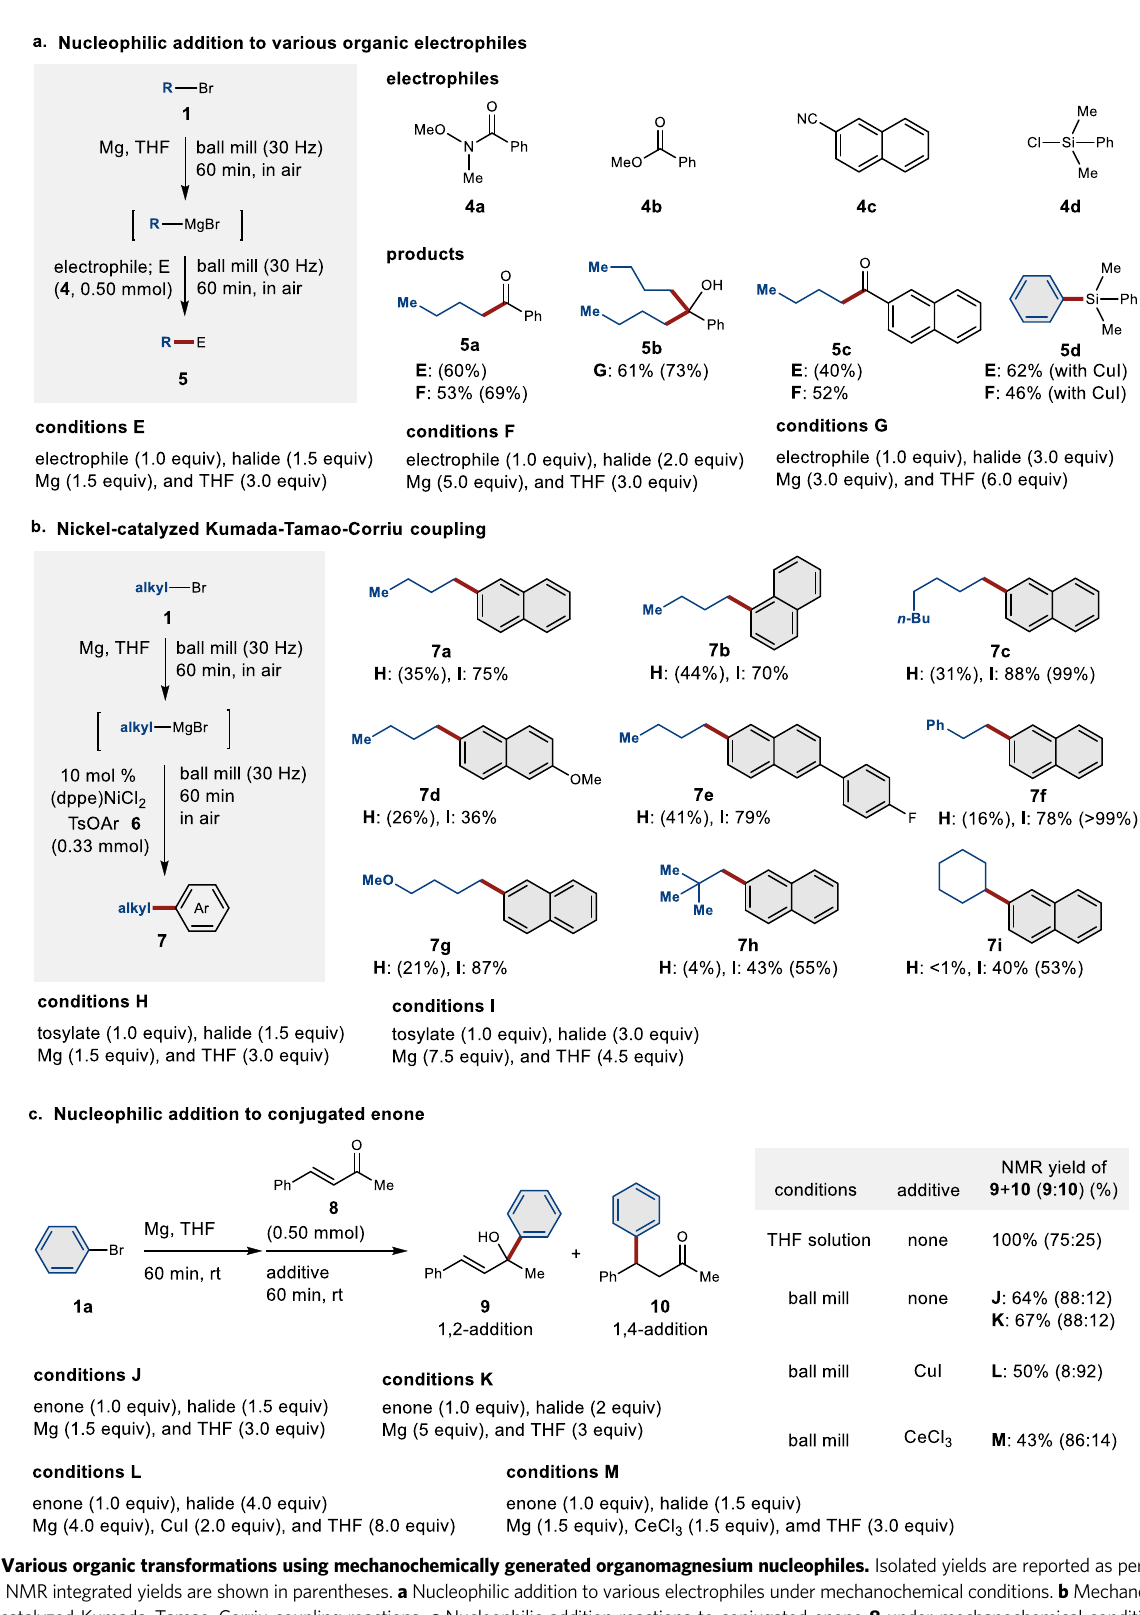
NATURE COMMUNICATIONS| (2021) 12:6691